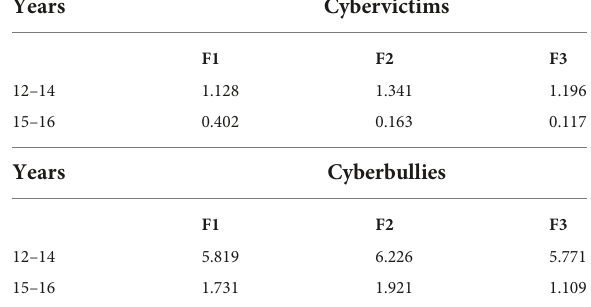
TABLE 4 Kruskal–Wallis H -test for cybervictims and cyberbullies according to the age range.